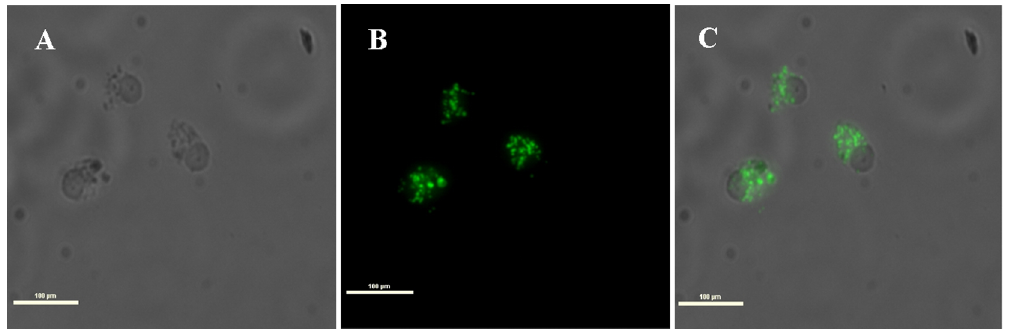
Figure 3. Immunofluorescence analysis of RTS11 cell line infected with P.salmonis grown in cell free medium (BM1). The figure shows bacteria inside the cells after 5 days post-infection. A: phase-contrast microscopy of RTS11 cell line infected with P. salmonis ; B: Immunofluorescence of A; C: Merge of A and B. The white bar indicates 100 m m. The images were digitalized using the 40 6 objective. doi:10.1371/journal.pone.0071830.g003 PLOS ONE |